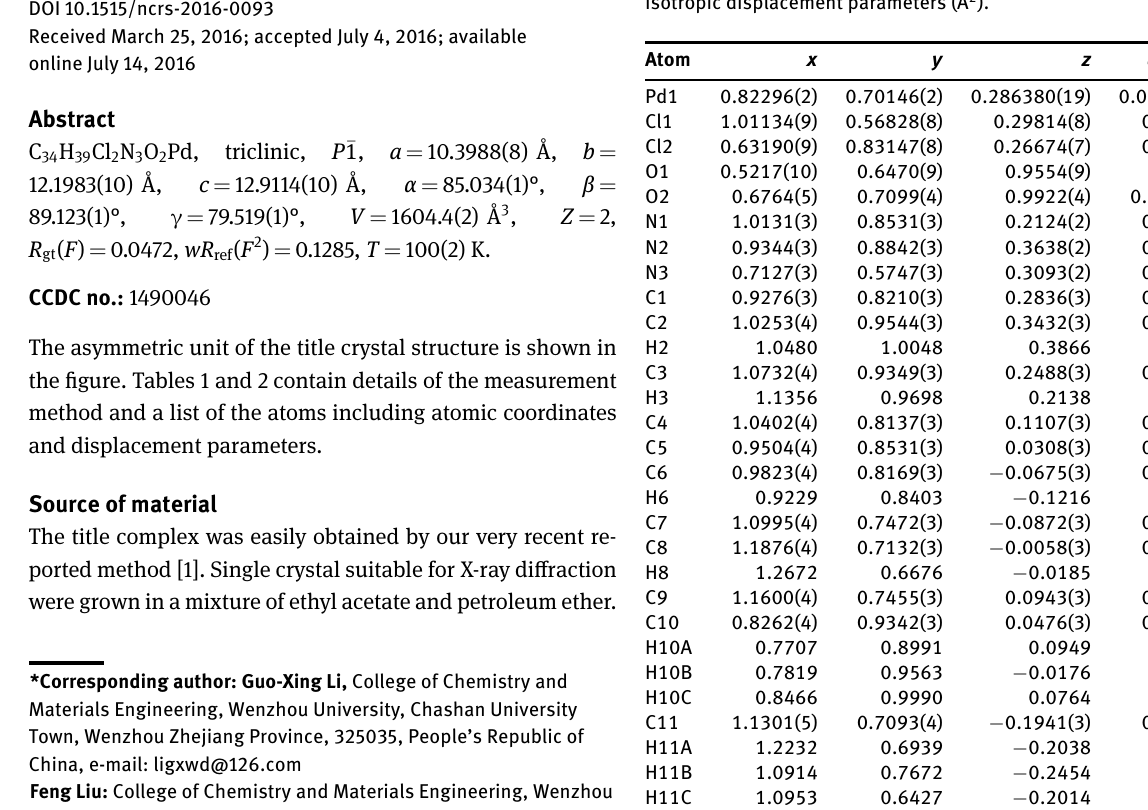
Table 2: Fractional atomic coordinates and isotropic or equivalent isotropic displacement parameters (Å 2